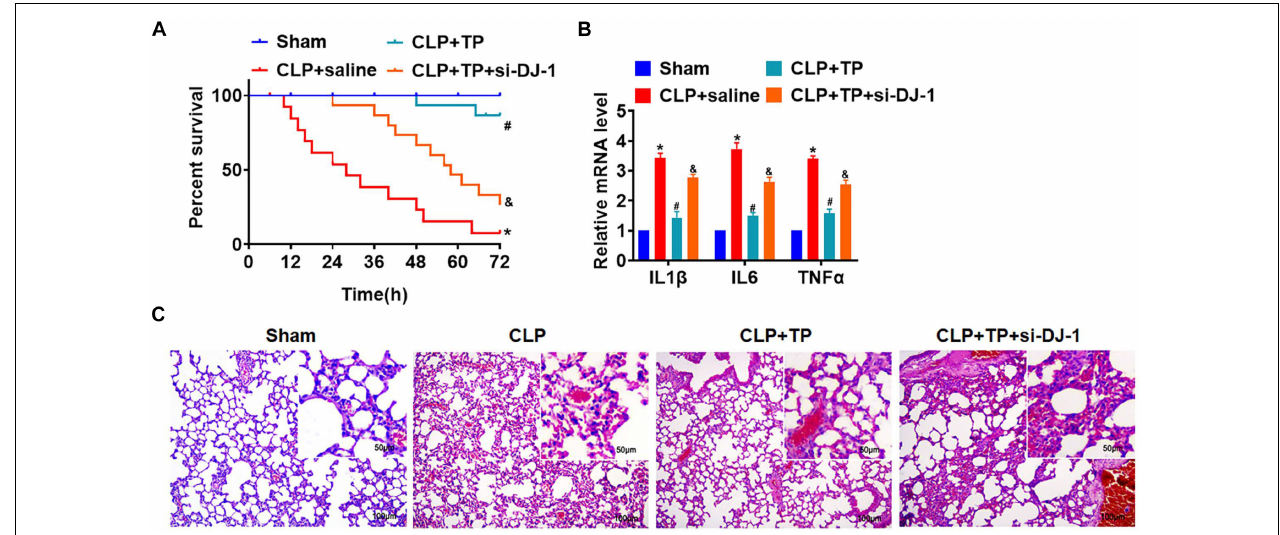
FIGURE 6 | Blocking DJ-1 inhibited the effect of TP on lung injury in vivo . Rats were suffered from CLP or sham surgery with or without TP (15 mg/kg), and rats were injected with lentivirus containing si-DJ-1. (A) Survival curves of rats. (B) H&E staining for lung sections. (C) The mRNA expression of inflammatory factors (IL1 β , IL6, and TNF α ). n = 4; * P < 0.05 vs. Sham, # P < 0.05 vs.